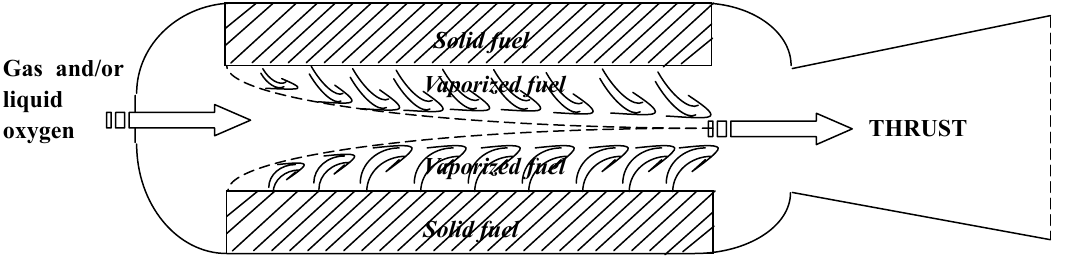
Figure 1. Schematic of the combustion process in a Hybrid Rocket Engine. Solid fuel Vaporized